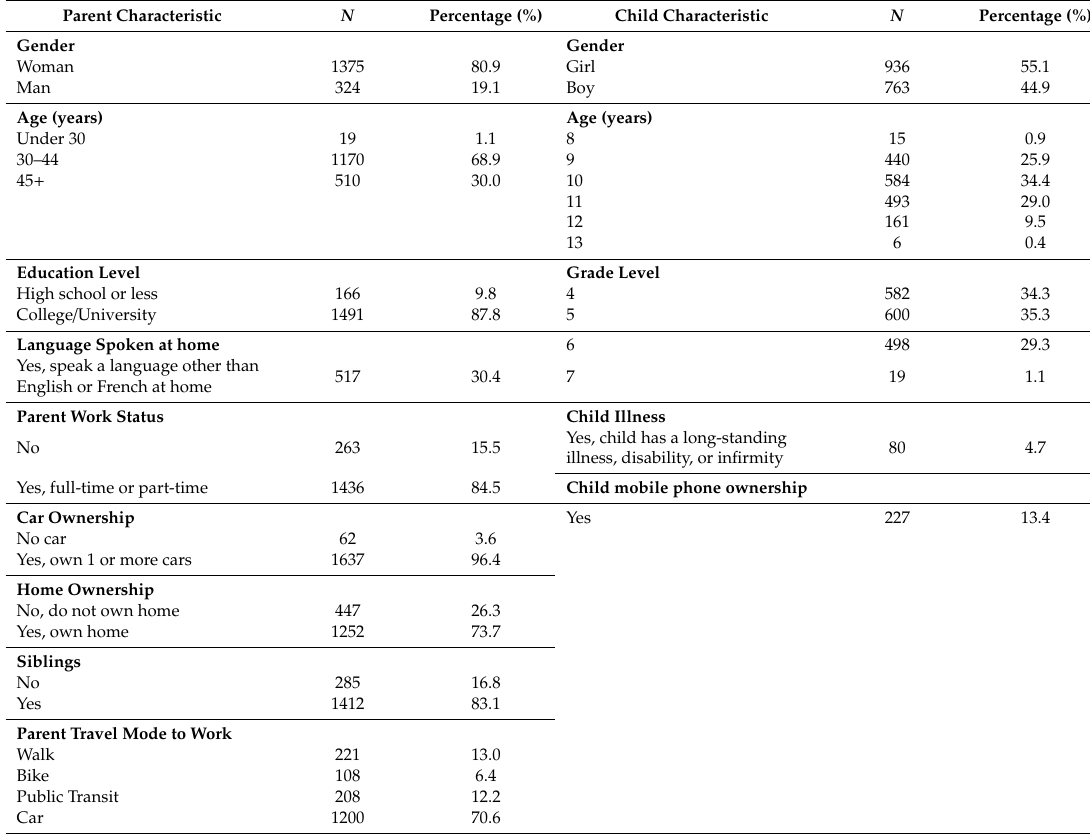
Table 1. Descriptive characteristics of the study sample ( n =